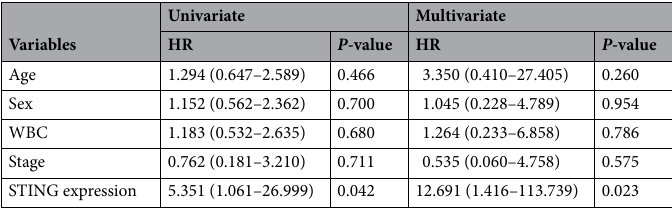
Table 2. Univariate and multivariate